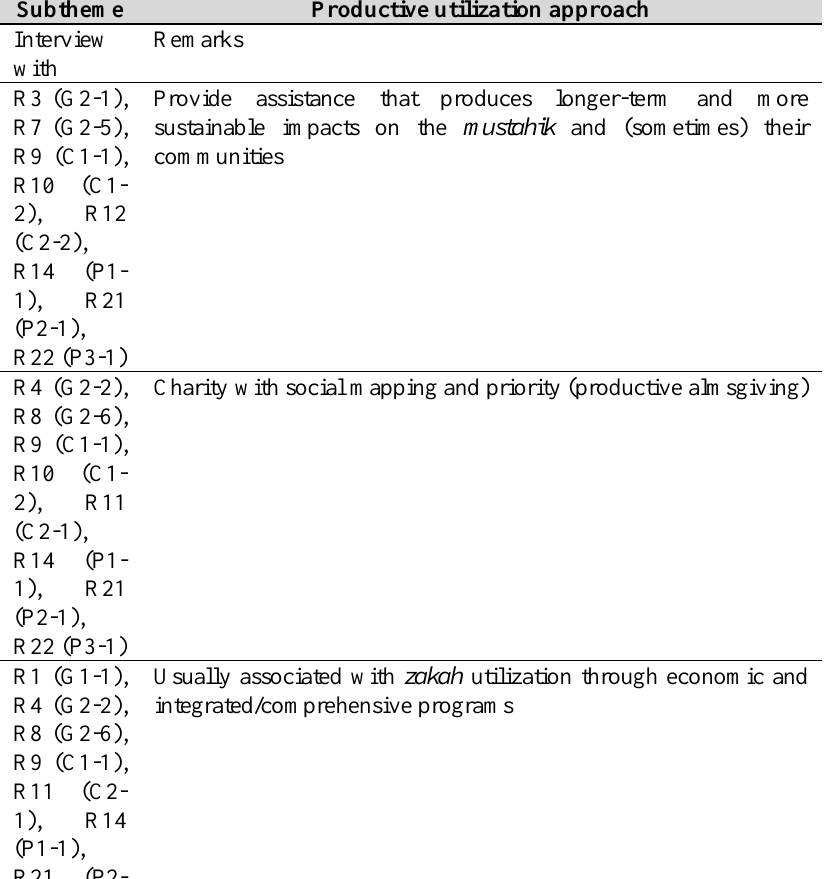
Table 4 Focused Coding 2 for the Distribution